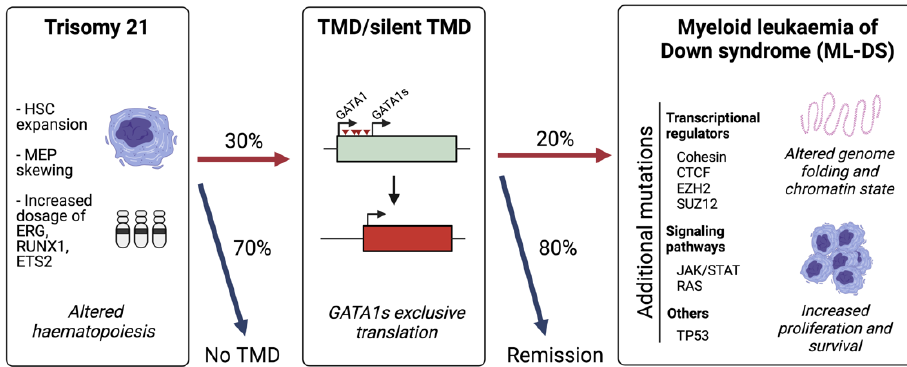
Figure 1. The sequential acquisition of mutations in ML-DS. Trisomy 21 alters foetal haematopoiesis causing an expansion of haematopoietic stem cells (HSCs) with skewing towards megakaryocyte- erythroid progenitors (MEPs). A total of 30% of Down syndrome (DS) neonates acquire mutations in GATA1 which lead to the exclusive production of the short isoform, GATA1s, which promotes a transient myeloproliferative disorder (TMD). A total of 20% of children with TMD will develop myeloid leukaemia of Down syndrome (ML-DS) following the acquisition of secondary mutations.